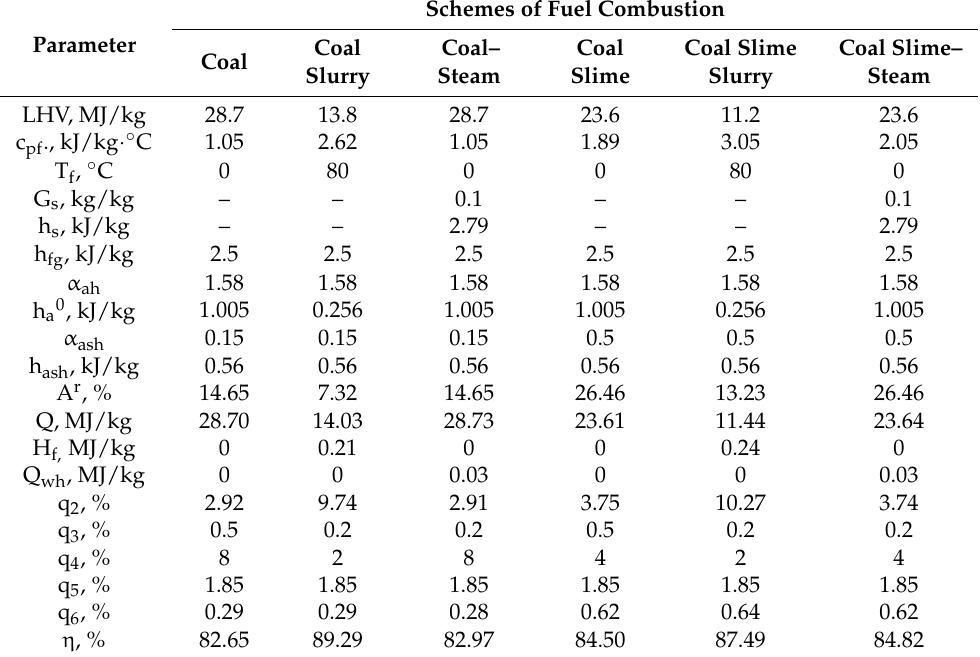
Table 3. Calculation results of boiler heat balance.